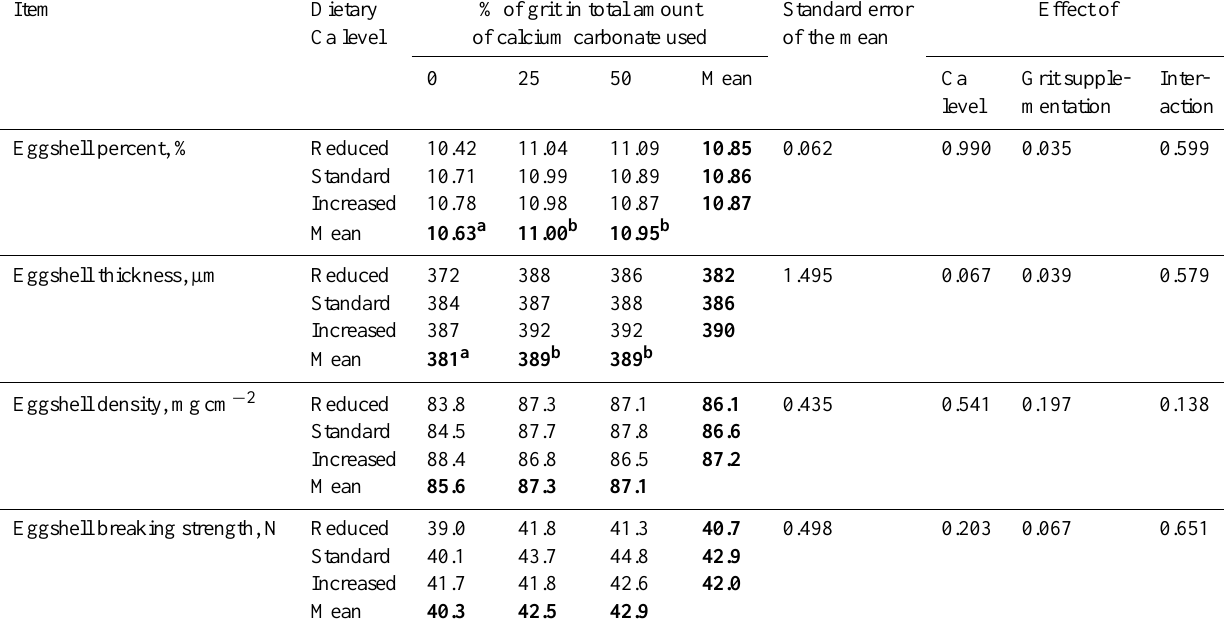
Table 4. Effects of dietary treatments on eggshell quality at 56 weeks of age. Item